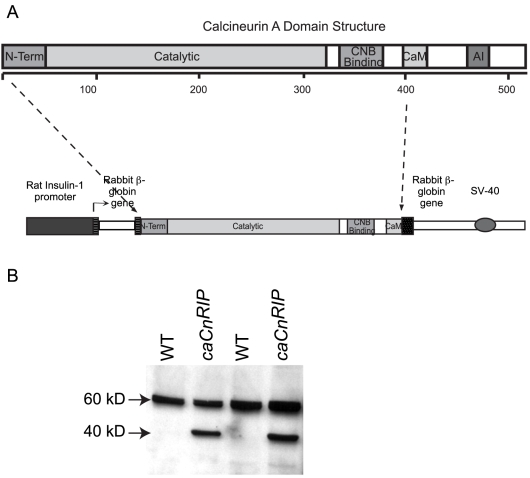
Transgene construct and expression in islet lysates from WT and caCnRIP mice.
A. Domain structure of calcineurin A. The mutant form including the first 1259 bp (400 amino acids) was subcloned into a vector containing the rat insulin promoter. B. Immunoblotting for calcineurin using islet lysates from WT and caCnRIP mice. The endogenous calcineurin A band migrates at 60 kD and the caCn mutant at 40 kD. The western is representative of two experiments performed in duplicate.